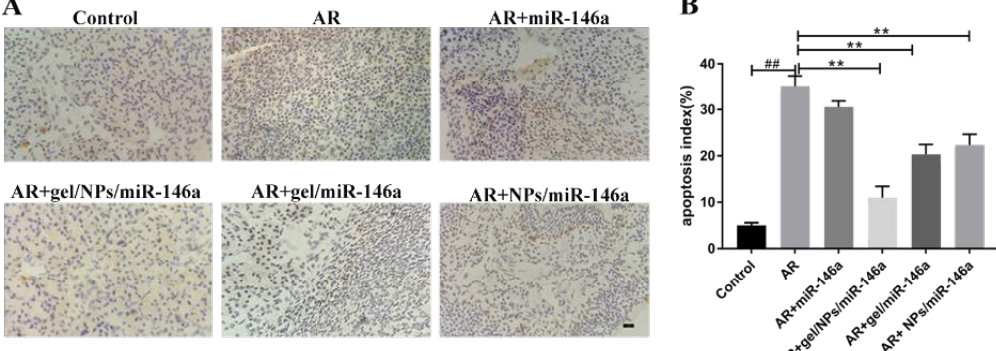
Figure 6. ( A ) Apoptosis of nasal epithelial cells determined by TUNEL staining (400 × ). ( B ) Quantitative analysis of the apoptosis rate of nasal epithelial cells. Data represent the mean ± SD of three independent experiments. ## p < 0.01 compared with the control group; ** p < 0.01 compared with the AR group.